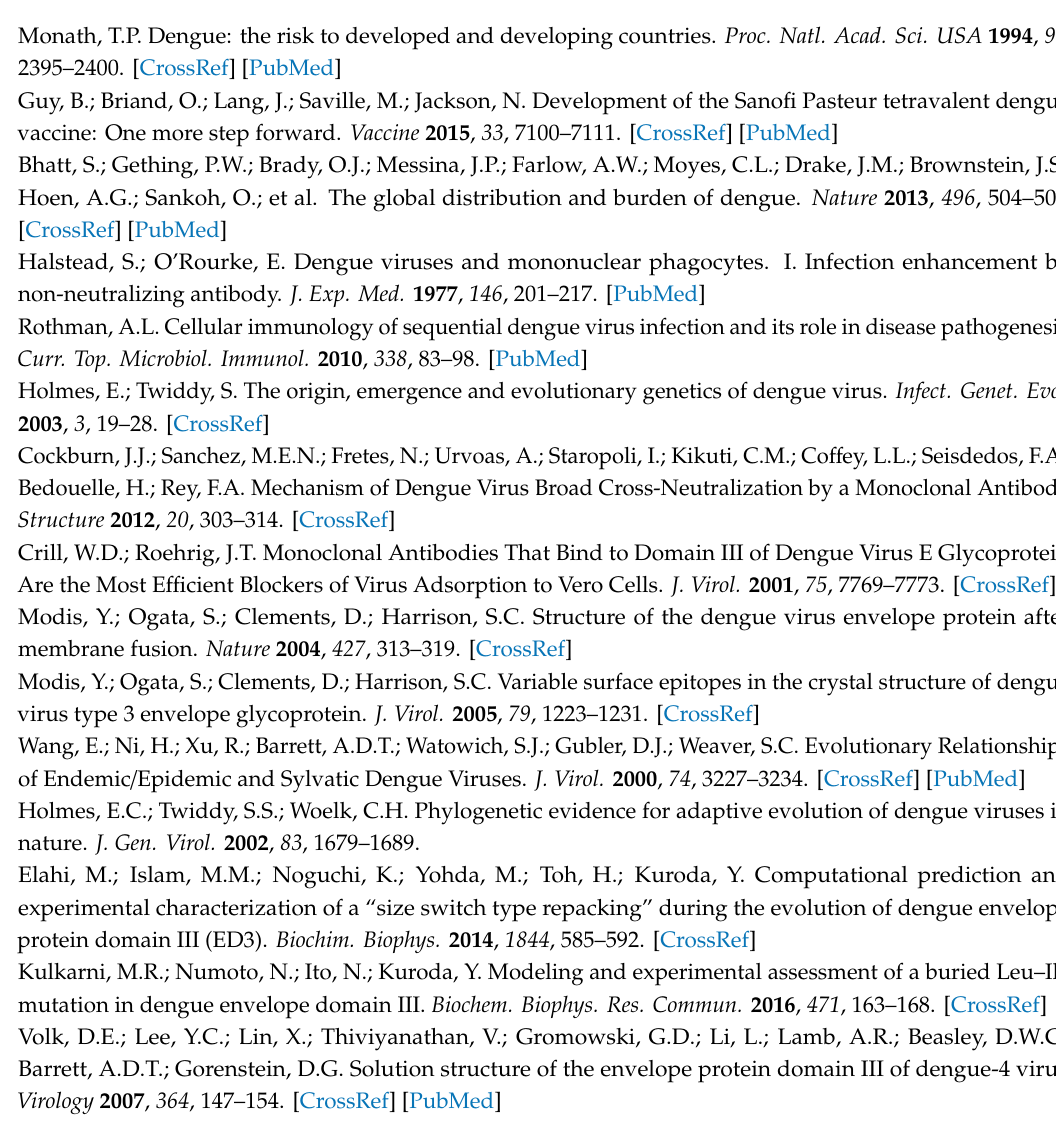
Figure S1: Sequence alignment of the four serotypes of DEN-D3. Figure S2: Average amide chemical-shift variations. Figure S3: Representative examples of fits obtained for the decrease in intensity with pressure of HSQC cross-peaks. Figure S4: Steady-State experiments followed by High-Pressure 1D Proton NMR. Figure S5: SDS-PAGE analysis of { 15 N} His-DEN4 ED3 protein before and after thrombin cleavage. Figure S6: Analytical reverse phase HPLC chromatogram and MALDI-TOF spectrum of { 15 N} DEN4 ED3. Table S1: Sequential and structural similarity among ED3’s of four dengue serotypes. Table S2: Exchange rates and Protection Factors (PF) measured for amide protons involved in the main chain hydrogen bonds stabilizing the ß-sheets found in